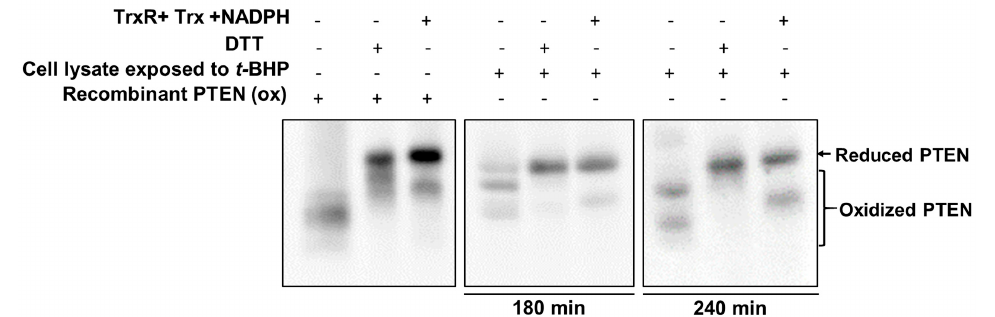
Figure 3. Reduction of the oxidized PTEN by exogenous Trx system. HeLa cells were treated with 0.5 mM t -BHP to oxidize endogenous PTEN for 180 and 240 min. After treatment, samples were alkylated with 20 mM NEM in the presence of 20 mM Tris-HCl (pH 7.4), 150 mM NaCl, 5% glycerol, 0.1% Nonidet P40 and protease inhibitor, the supernatant was applied to NAP-5 desalting column equilibrated with lysis buffer to remove excess NEM. Recombinant PTEN (oxidized form) and cleared cell lysates were untreated or treated with DTT or with a combination of thioredoxin (Trx) system components (Trx1, TrxR1 and NADPH) and analyzed on non-reducing SDS-PAGE, followed by immunoblotting with PTEN antibodies.